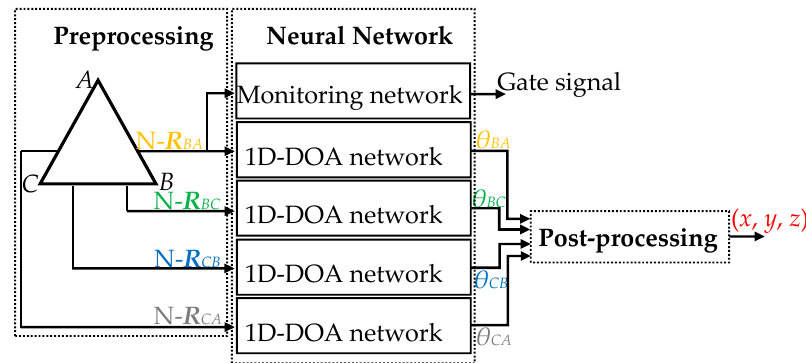
Figure 6. Block diagram of the 3D-DOA estimation model.